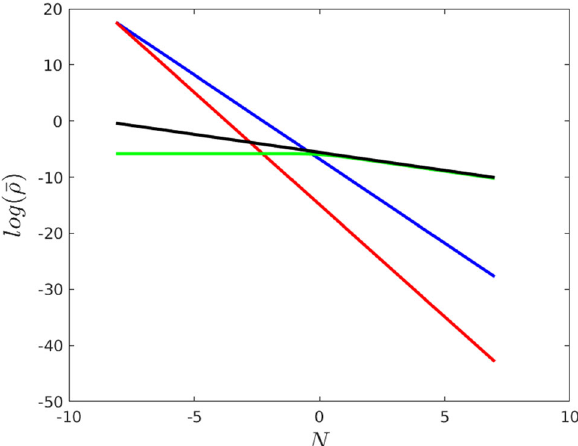
Fig. 3 Reduced densities ¯ ρ m (blue curve), ¯ ρ r (red curve), ¯ ρ ϕ (green curve),and ρ tr (blackcurve)inlogscale,frommatter-radiationequality to the future have been shown. One can clearly see that after a certain value of N , ¯ ρ ϕ (green curve) coincides with the tracker solution ¯ ρ tr (black